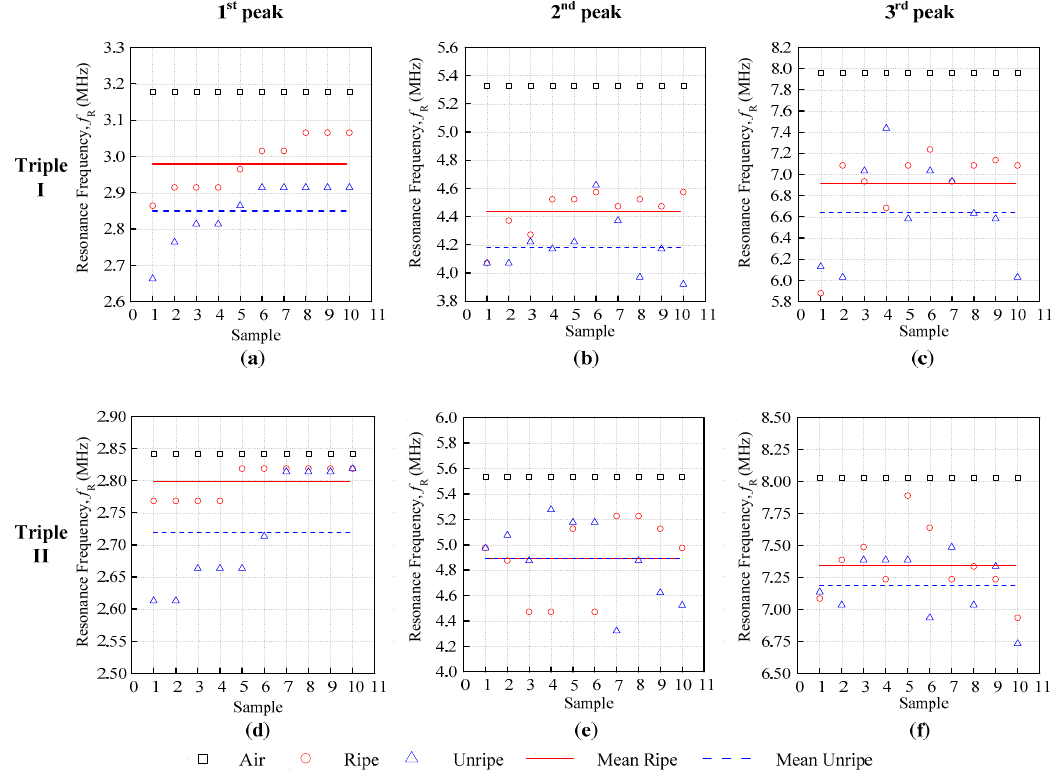
Figure 9. Ripe-unripe first, second, and third peak resonance frequency comparison for Triple I ( a – c ) and Triple II ( d – f ).